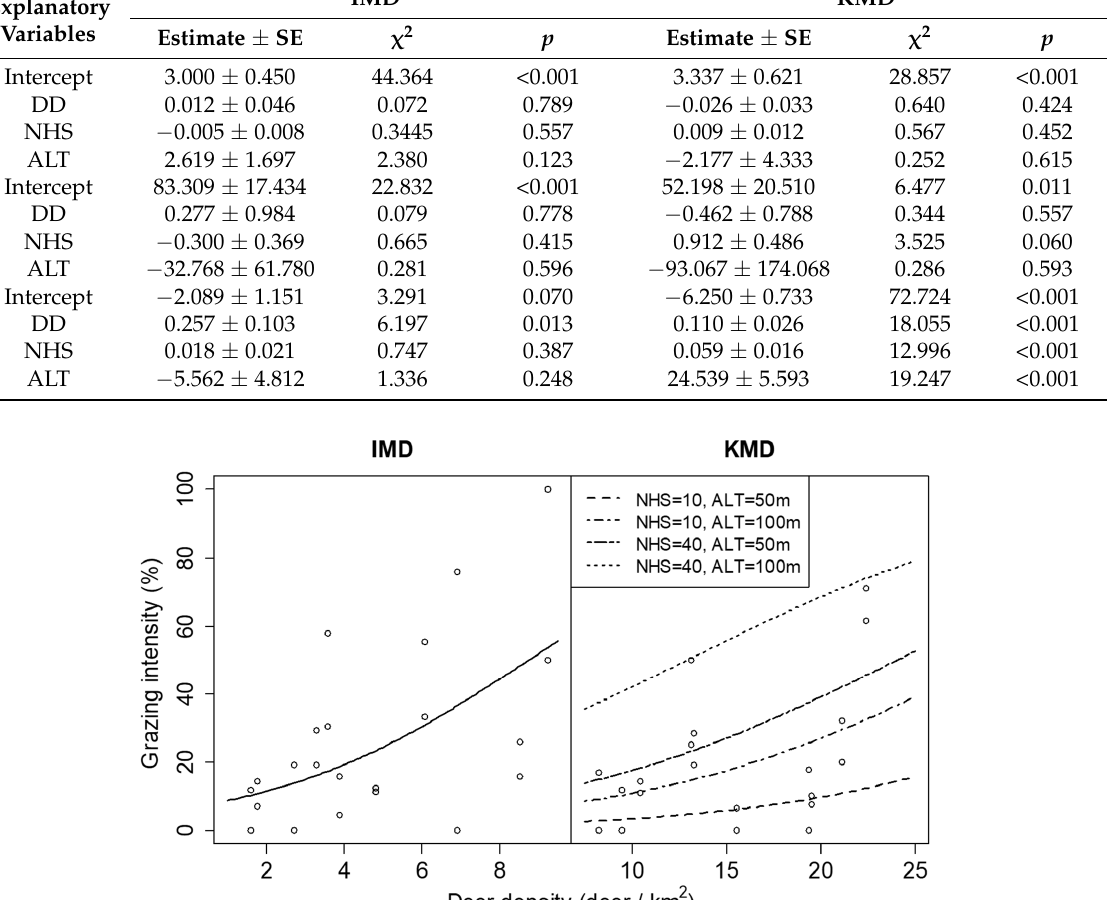
Figure 8. Relationship between grazing intensity of Dryopteris crassirhizoma and deer density in Iburi Management District (IMD) and Kushiro management district (KMD) in 2014. Lines are predictions of the generalized linear mixed models and show significant relationships ( p < 0.05). Lines for KMD represent the cases where the number of herbaceous species (NHS) was 10 or 40 species and altitude (ALT) was 50 or 100 m.